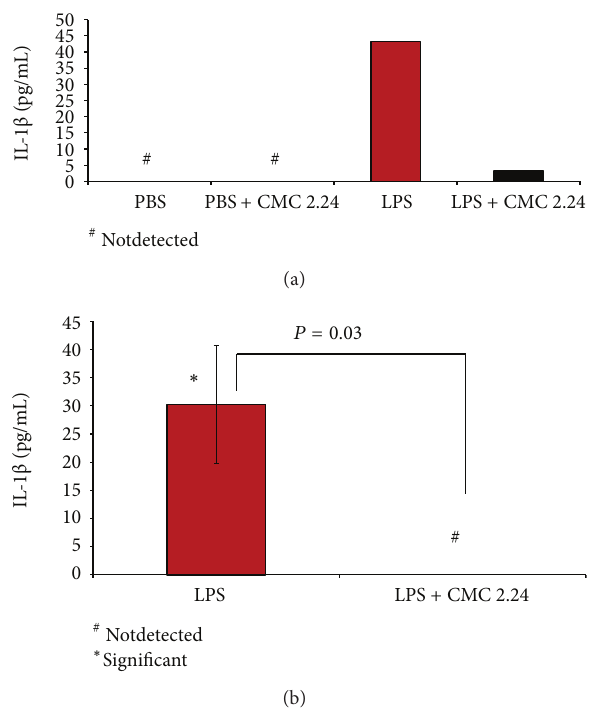
Figure 5: (a) The effect of CMC therapy on IL-1 𝛽 in rat gingiva (top) and (b) serum (bottom) measured by